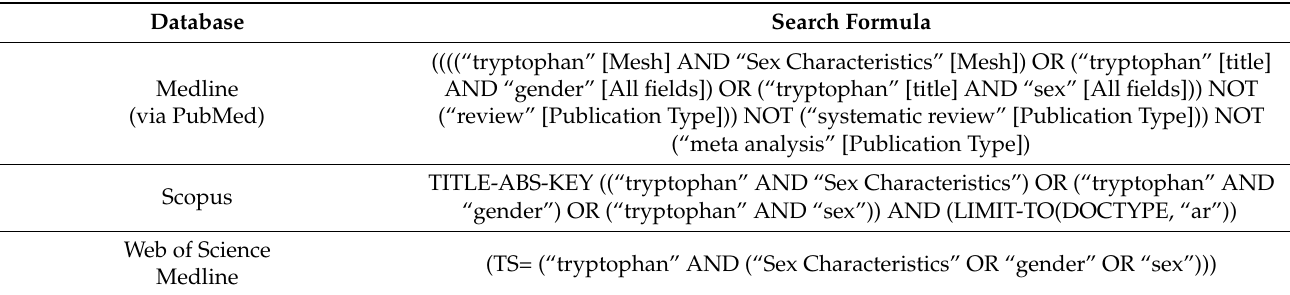
Table 7. Search strategy